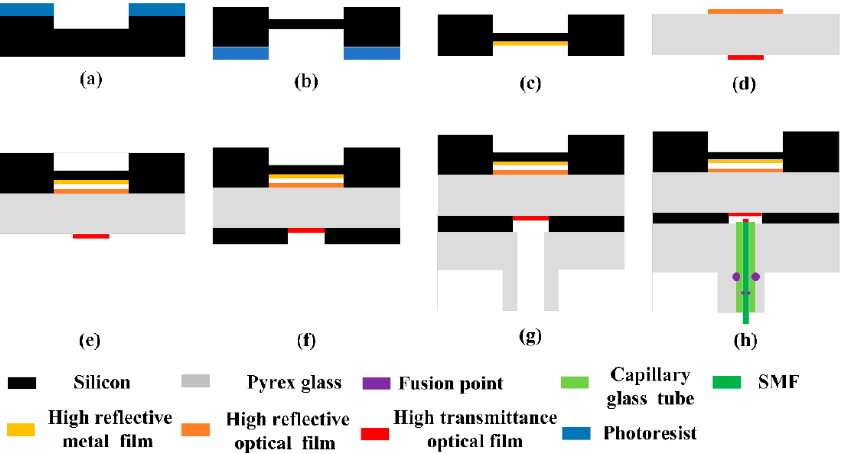
Figure 4. The manufacturing process of a high-temperature fiber-optic Fabry–Perot pressure sensor: ( a ) deep silicon etching on the silicon surface of Fabry-Perot cavity., ( b ) deep silicon etching on the silicon surface of the pressure-sensitive surface., ( c ) plating metal film on the silicon surface in the Fabry-Perot cavity, ( d ) plating dielectric films on two surfaces of Pyrex glass, ( e ) anodic bonding between the sensitive silicon diaphragm and the glass back plate, ( f ) anodic bonding between the glass back plate and the through-hole silicon, ( g ) anodic bonding between the through-hole silicon and the glass cover plate, and ( h ) the capillary tube with optical fiber and the sensitive unit are welded.